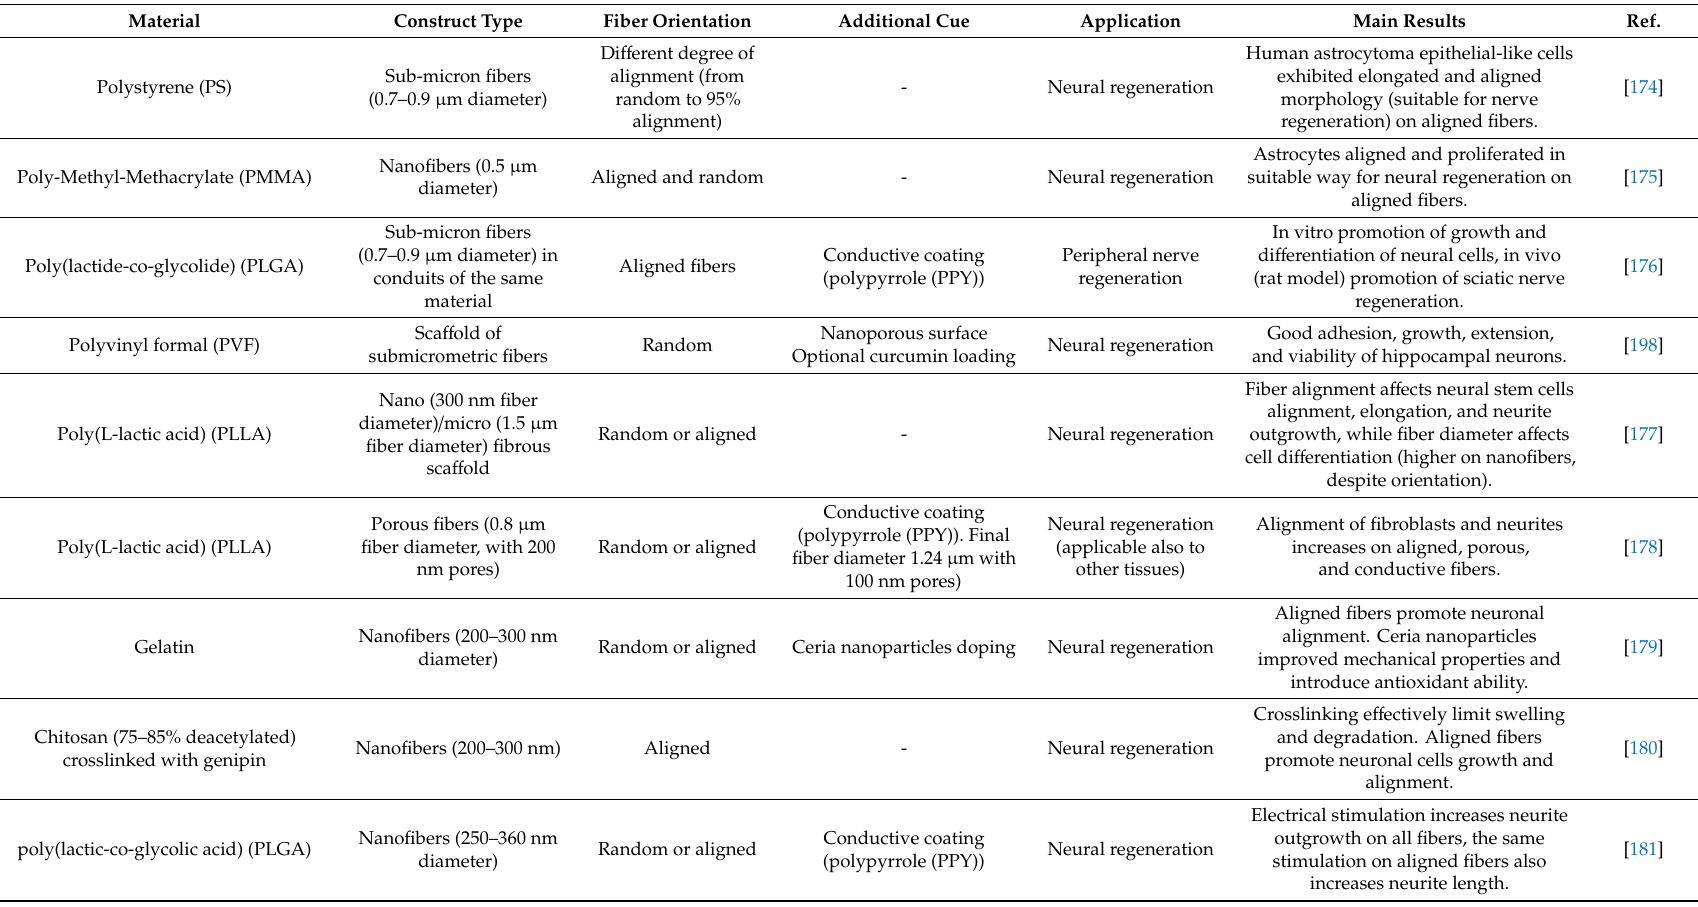
Table 2. Topographical and biochemical cues in electrospun fibers for various implantable device applications (in vitro / in vivo